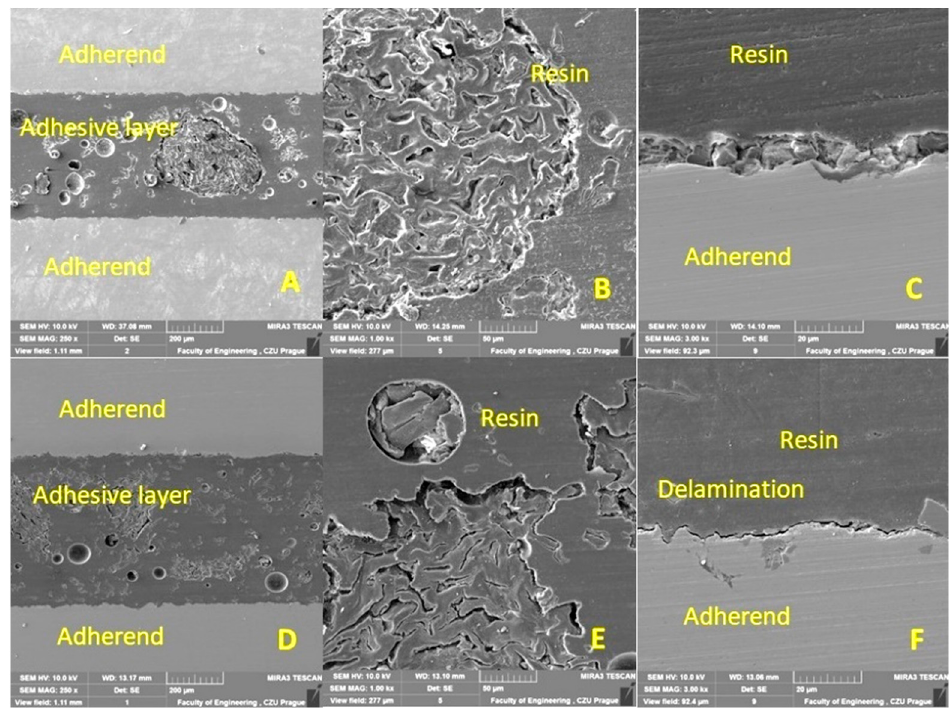
Figure 13. SEM analysis of the cross-section of the hybrid adhesive layer with J filler (SE detector Oxford): ( A ): Cross section of the hybrid adhesive layer with filler J (MAG 250×), ( B ): Interaction between J filler and resin (MAG 1000×), ( C ): Interaction between hybrid adhesive layer and ad- herend (MAG 3000×), ( D ): Cross-section of hybrid adhesive bond with filler J_NaOH (MAG 250×), ( E ): Interaction between filler J_NaOH and resin (MAG 1000×), ( F ): Interaction between hybrid adhesive layer and adherend (MAG 3000×).